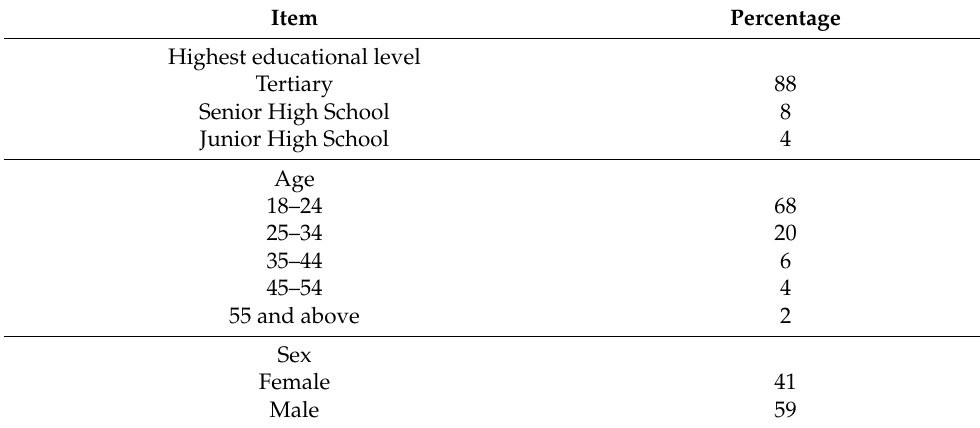
Table 1. Profile of